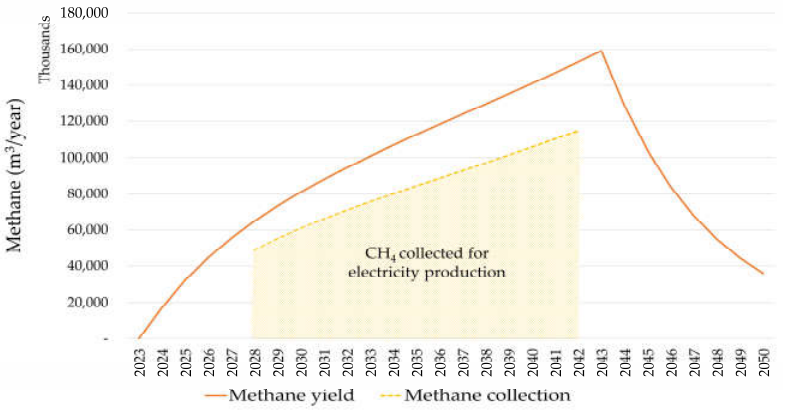
Figure 3. Annual landfill methane generation and collection.